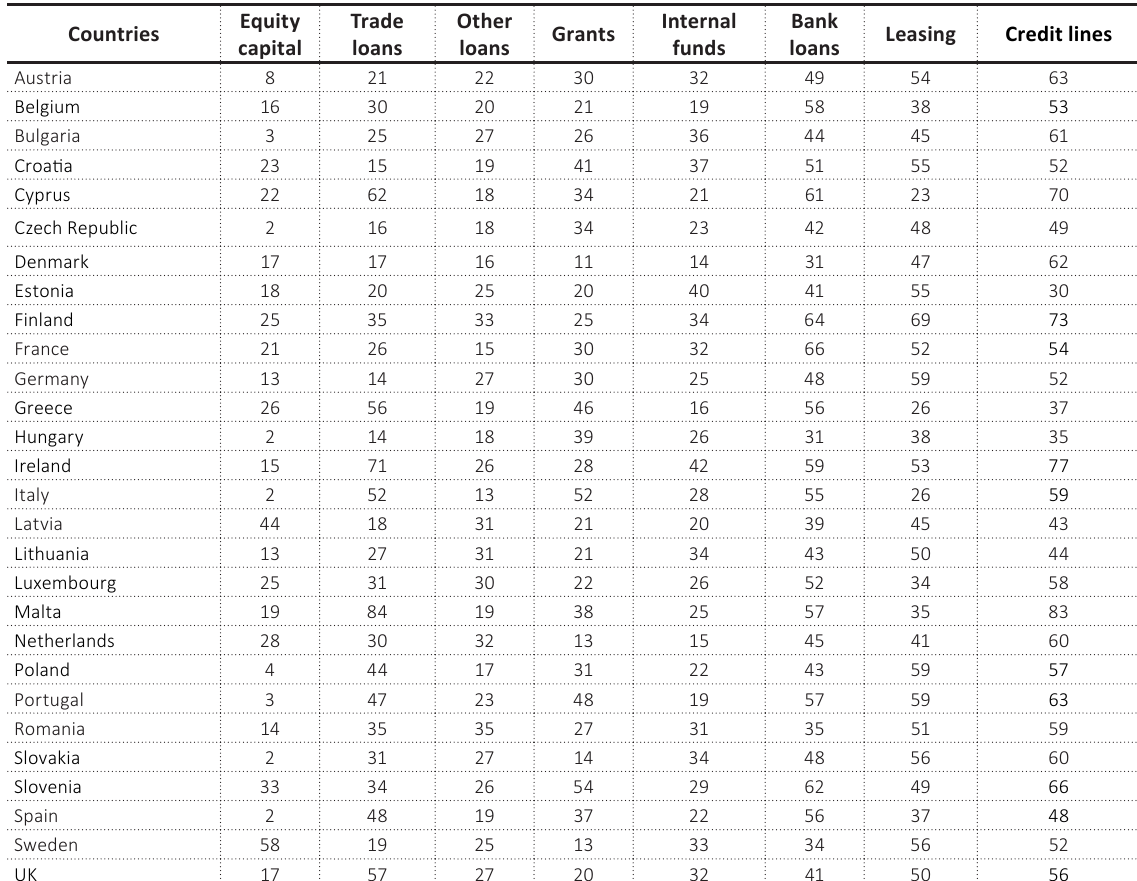
Source: Based on OECD